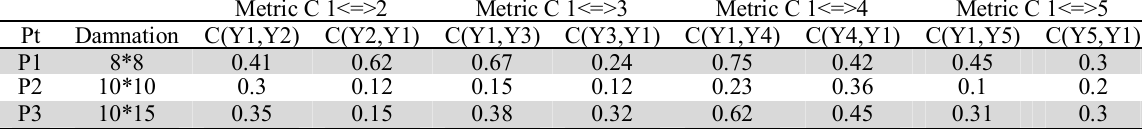
Comparing metric C Parameter for five algorithms running on three benchmark